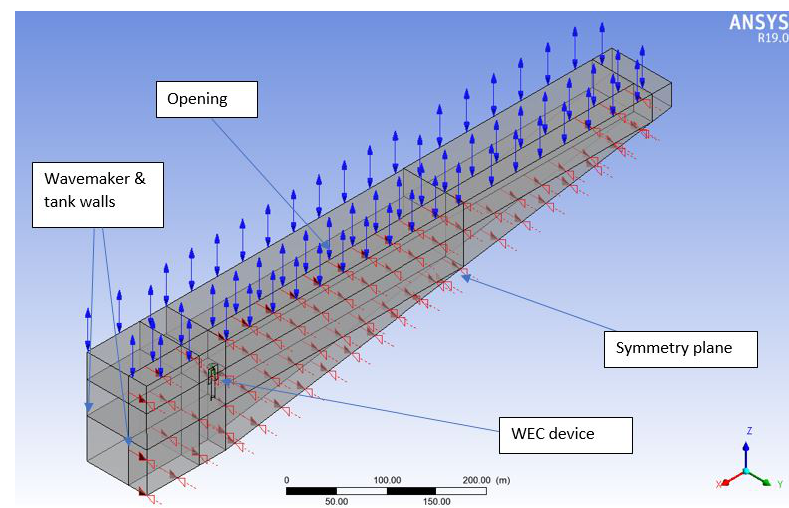
Figure 3. 3D wave tank and boundary conditions.